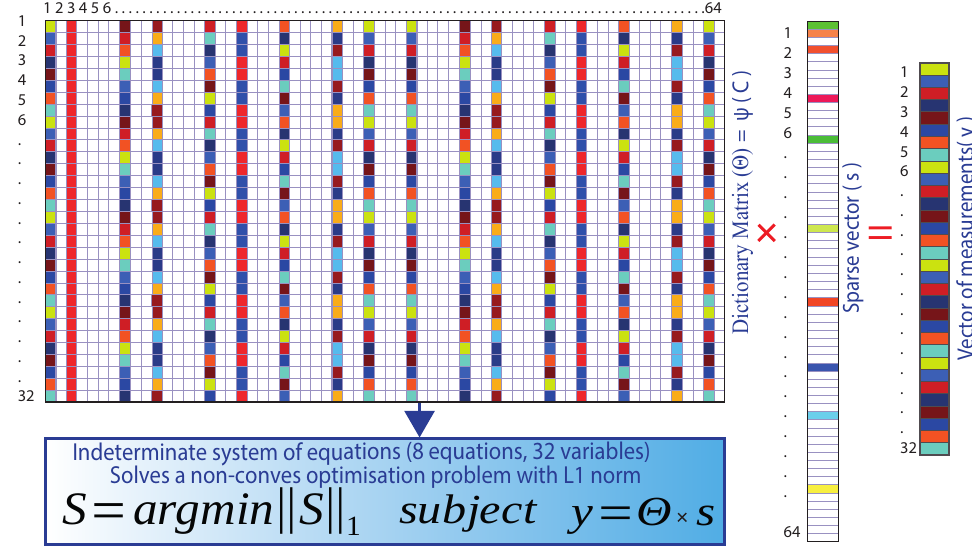
Figure 7. Indeterminate system of equations and its solution with the L1-norm. The minimum L1-norm solution is sparse, while the minimum L2-norm solution is sparse [33]. The linear indeterminate system of equations (Equation (4)) can be solved using the L2-norm with particular conditions that must be met for the L2 minimization to converge, but the solution is not sparse, as illustrated in Figure 8.